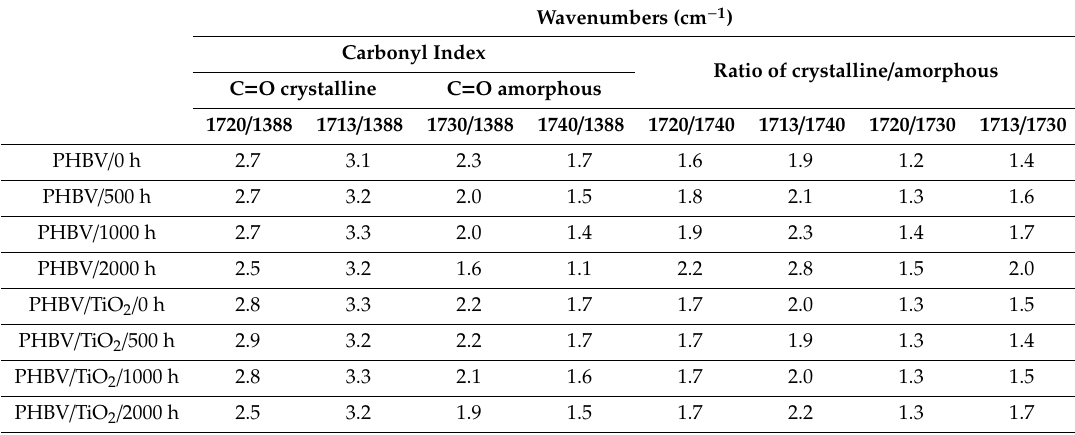
Figure 6. FTIR spectra of the neat PHBV before (0 h) and after (500, 1000 and 2000 h) accelerated weathering ( A ). Detailed area of: the stretching C=O vibration ( B ), the CH 3 deformations (1338 cm − 1 ), and the stretching C–O (1255–1245 cm − 1 and 1180 cm − 1 ) bands ( C ). Table 1. Carbonyl index and crystalline / amorphous ratios for the PHBV and the PHBV / TiO 2 nanocomposites, both before and after